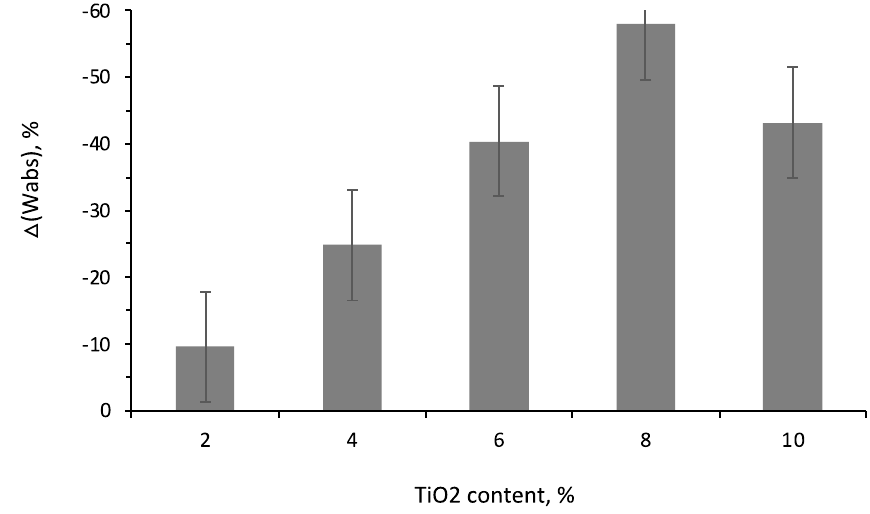
Figure 9. Effect of TiO 2 additions on Δ(W abs ) values.